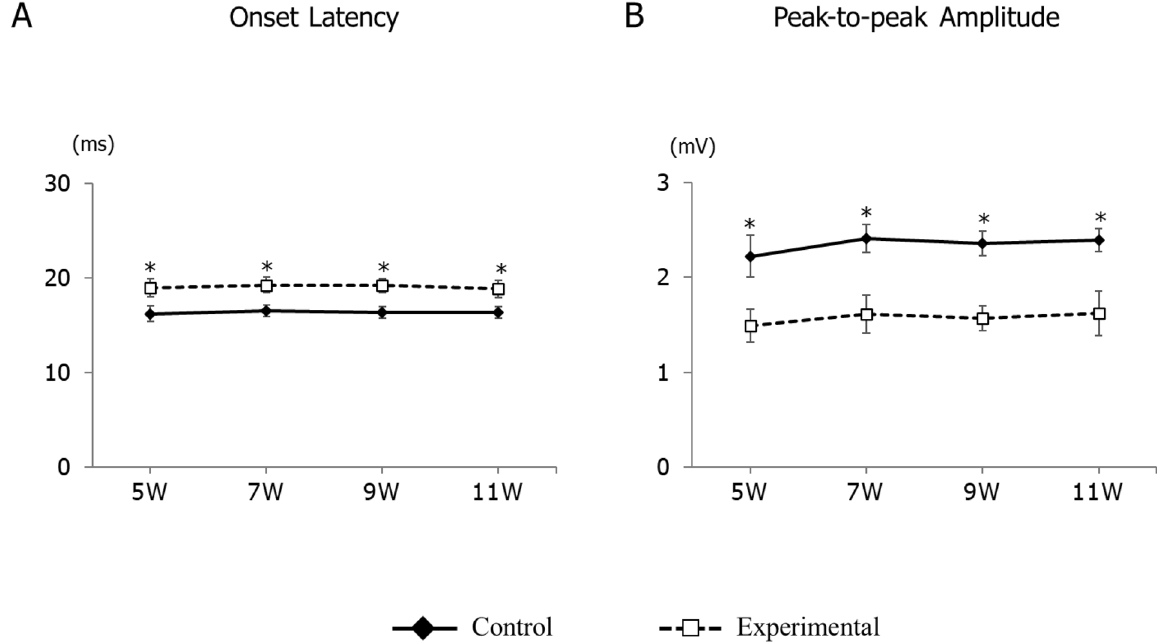
Figure 2. Longitudinal changes in electromyographic activity of onset latency ( A ) and peak-to-peak amplitude ( B ) in the control and experimental groups. Data are displayed as mean ± standard deviation. *p < 0.05 denotes significant differences between the control and experimental groups.